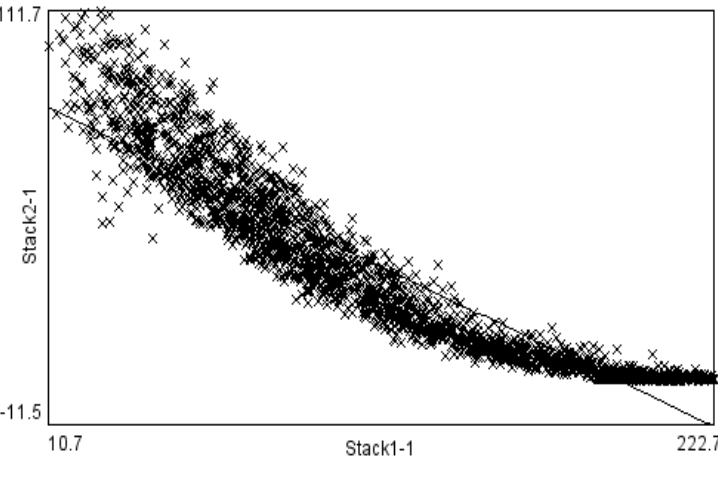
Figure 2. Pixel-to-pixel correlations of gray values between the two images (Fig. 1a and 1b): The transmission intensity is displayed on the X axis with black color corresponding to low readings (near 0) and white areas of uncovered glass corresponding to high x values, near 255. The fluorescence intensity (Y axis) is displayed in a similar fashion with black near 0 and highly fluorescent regions at high Y values. Linearity improves in the upper left corner where fluorescence is high and transmission low. Saturation is observed on bare glass, not covered with fractals [7]. Reprint with permission from [7]. Copyright (2007) American Chemical